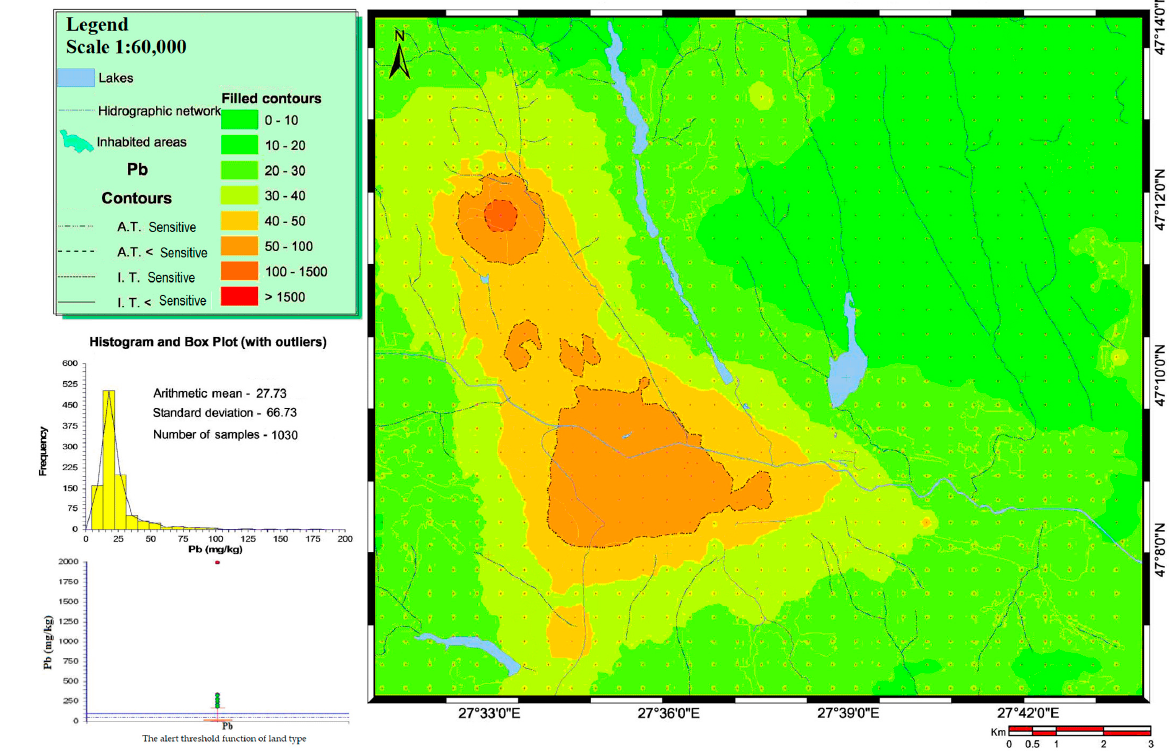
Figure 5. Map of Pb distribution in the analysed soil (mg kg − 1 ).